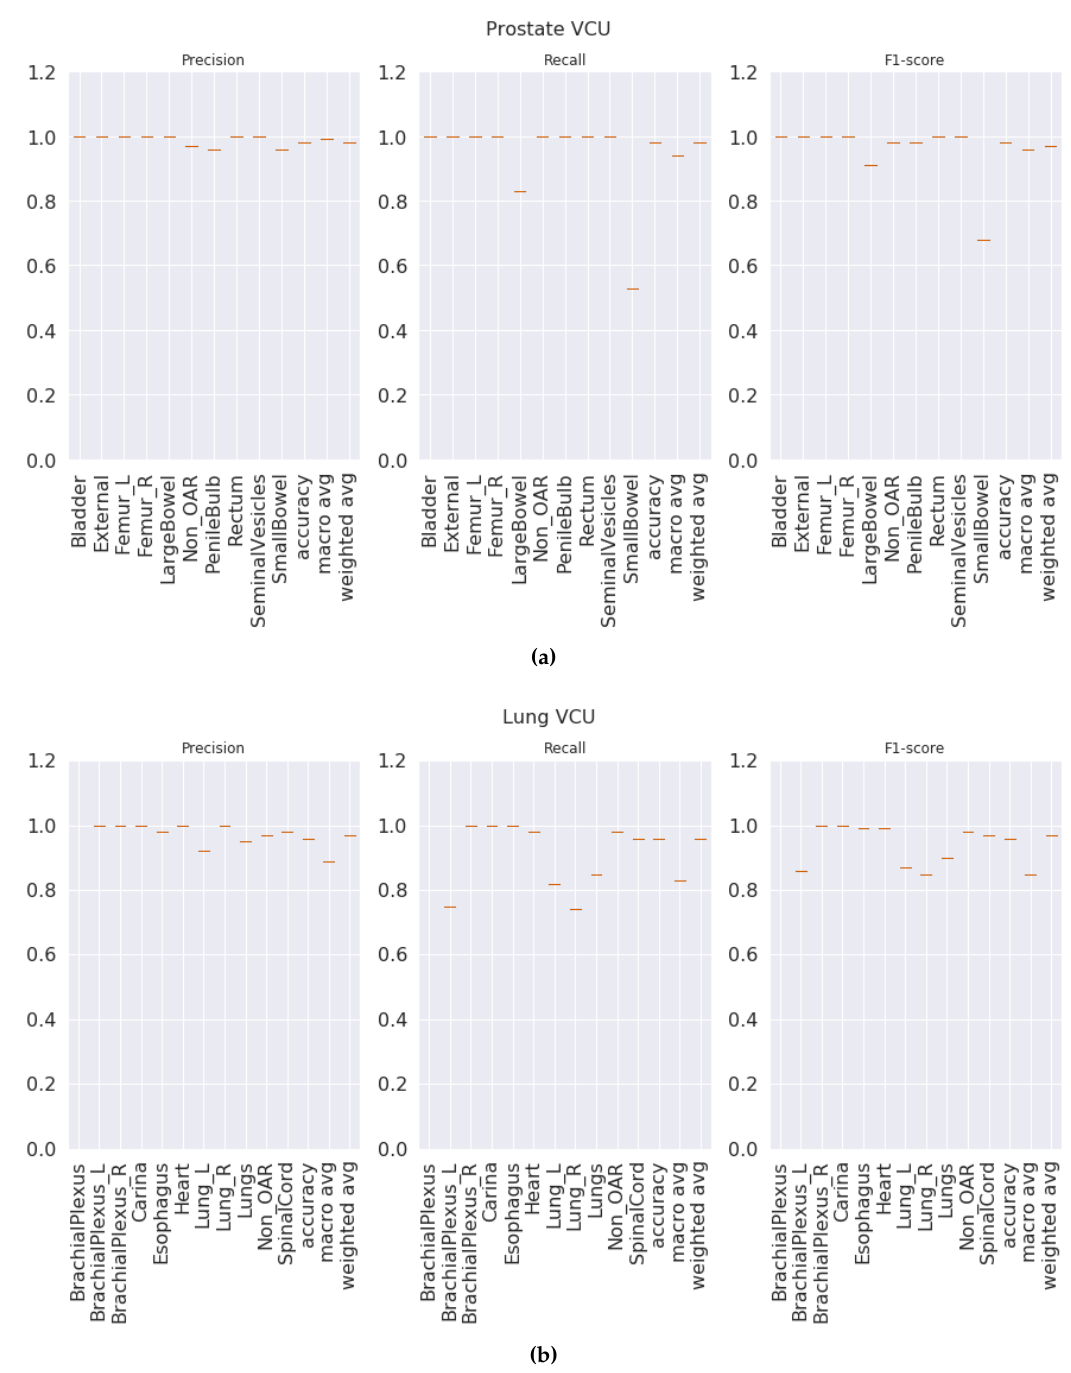
Figure 5. Test results (VCU dataset): ( a ) prostate, ( b )